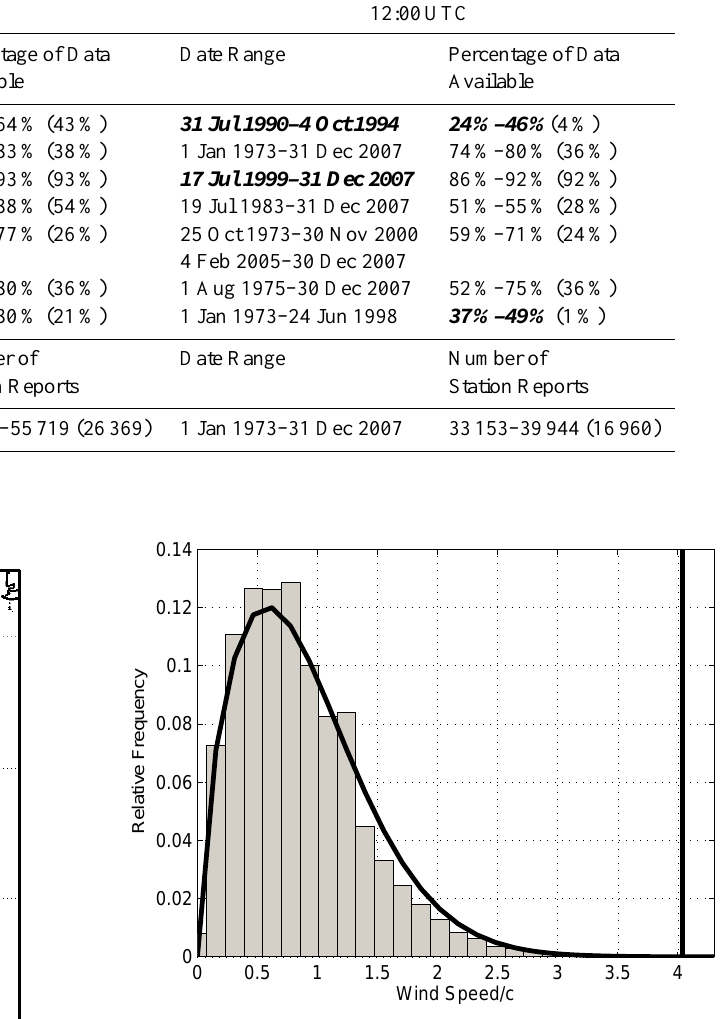
Fig. 2. Frequency histogram of the scaled wind speed at 850mb for all 7 stations on MP from 1973 to 2007 using a bin size of 2knots. The frequency is normalized over the total number of measure- ments. The thick curve is the empirically fitted Weibull distribution with shape parameter k = 1 . 67 and scale parameter c = 12 . 9knots (or 6.62ms − 1 ) . The bold vertical line denotes the threshold v max = 52.1knots, beyond which wind speed data is flagged as